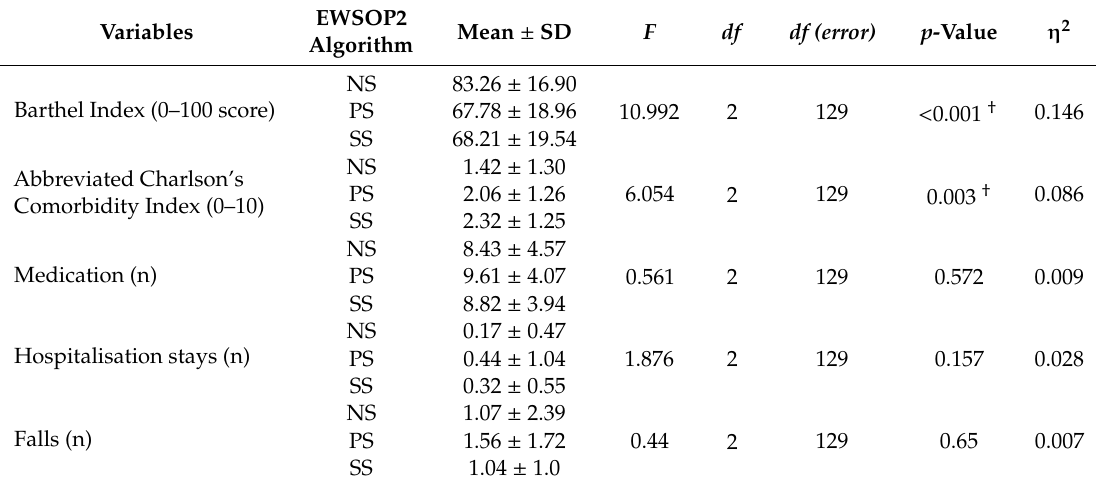
Table 2. Means, standard deviation and ANOVA results of the independent variables.